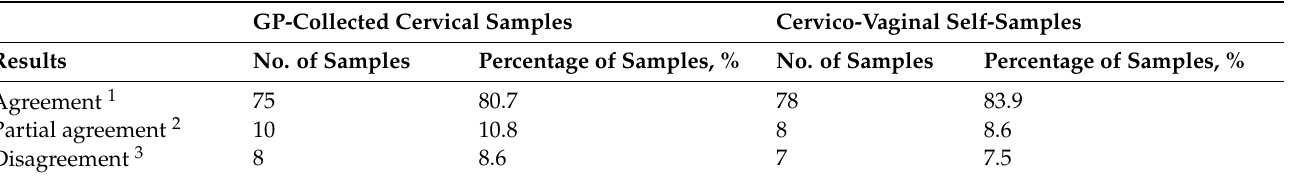
Table 3. Degree of agreement between the NGS assay and CLART ® HPV4S in GP-collected cervical samples and cervico-vaginal self-samples.